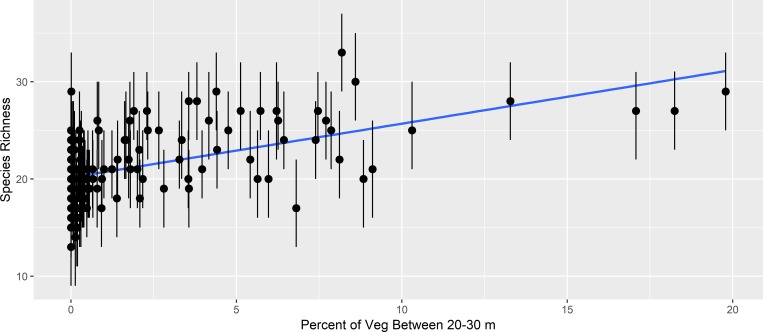
Posterior median species richness (estimated number of species at a given site of the 56 species we analyzed), shown with 95% credible intervals (error bars) and linear relationship (blue line), as a function of canopy density (vegetation from 20 to 30 m) at 156 points in coastal forests of eastern North Carolina, USA (2013–2015).